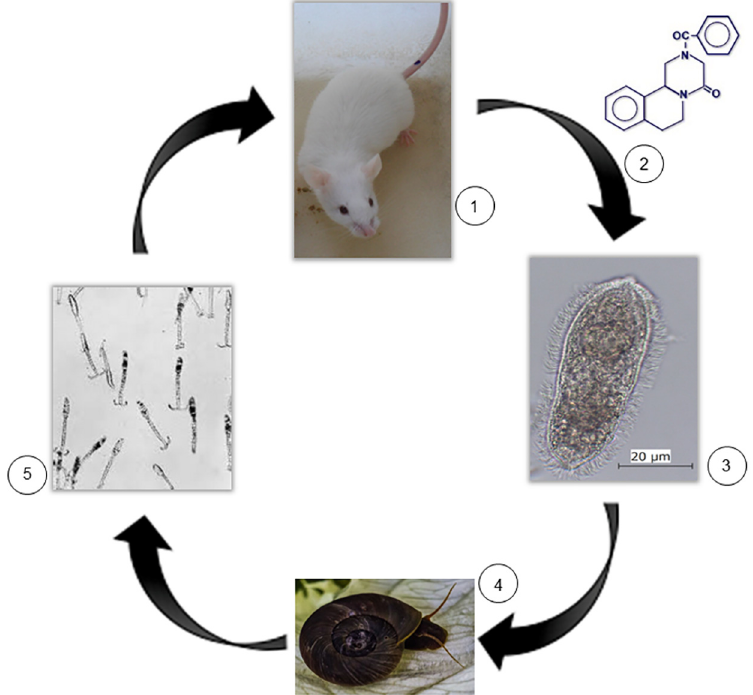
Fig 1. Selection of S . mansoni PZQ-resistant strain. This selection was carried out under continuous PZQ increased pressure using CD1 mice over several passages. 1 — Transcutaneous infection of mice with ~100 cercariae; 2 – Oral administration of PZQ after infection confirmation by the presence of eggs in the faeces ( ± 60 dpi); 3 – Mice were euthanized to collect adult worms and miracidia (eggs in faeces) ( ± 75 dpi); 4 — B . glabrata snails were infected with miracidia released from eggs; 5 — Cercariae were released from snails ( ± 45 dpi).